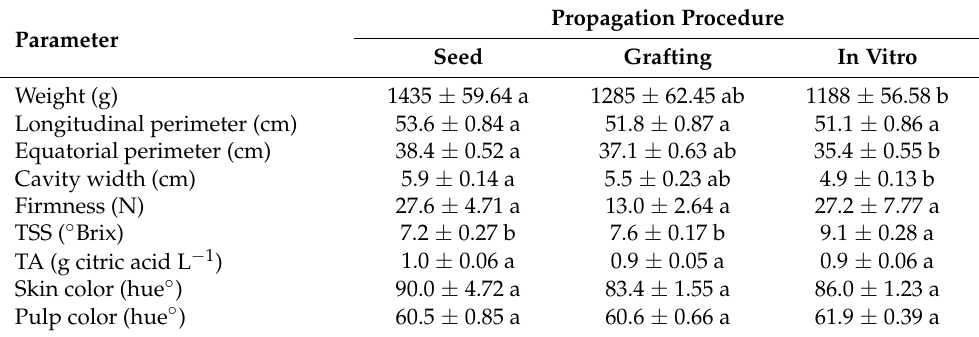
Table 4. Fruit size and quality at maturation (100% yellow skin color) (average ± s.e.) in ‘Alicia’